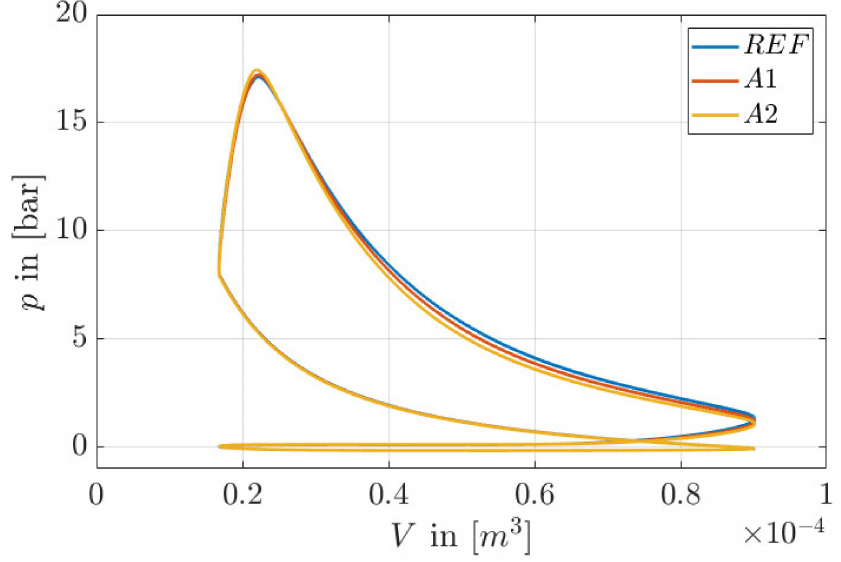
Figure 16. Comparison of trajectories REF, A1 and A2 related to the energy conversion of the internal combustion engine: cylinder pressure depending on